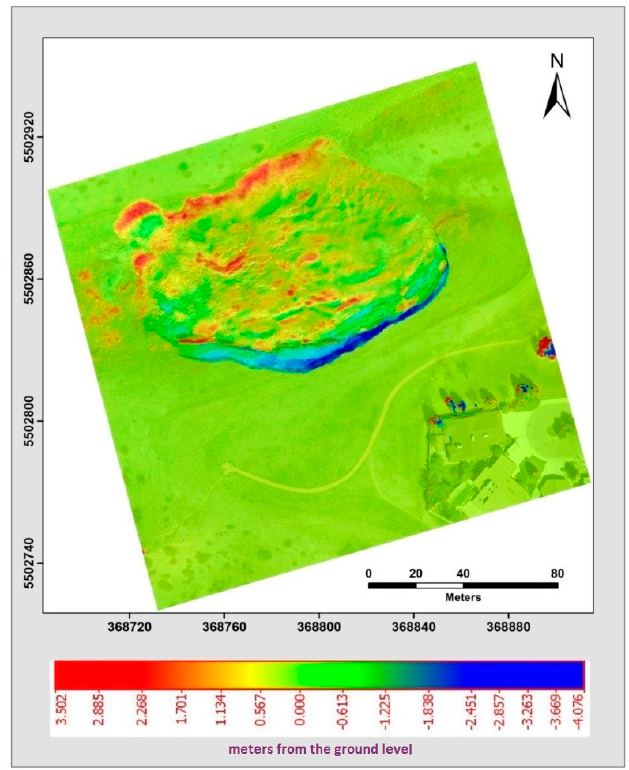
Figure 13. Illustrates the height difference in meters between the point cloud surfaces created from low altitude UAV imagery obtained in two different epochs in May 2014 and May 2015. For each point, the distance, from the ground level on top of the landslide is either positive (red) due to deposition or negative (blue) due to erosion.